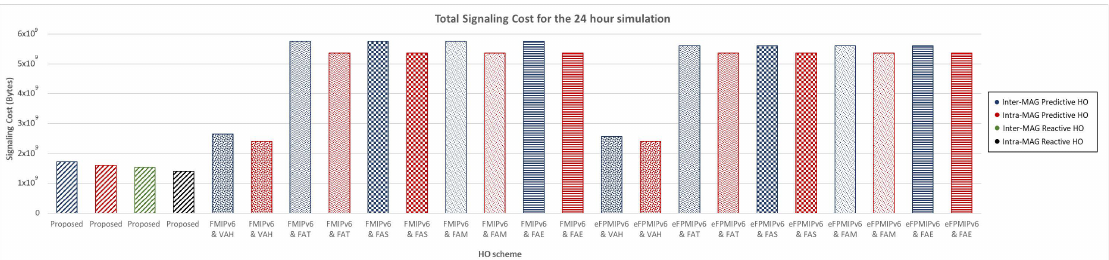
Figure 22. The total signaling cost of each HO scheme during the 24 h simulation.